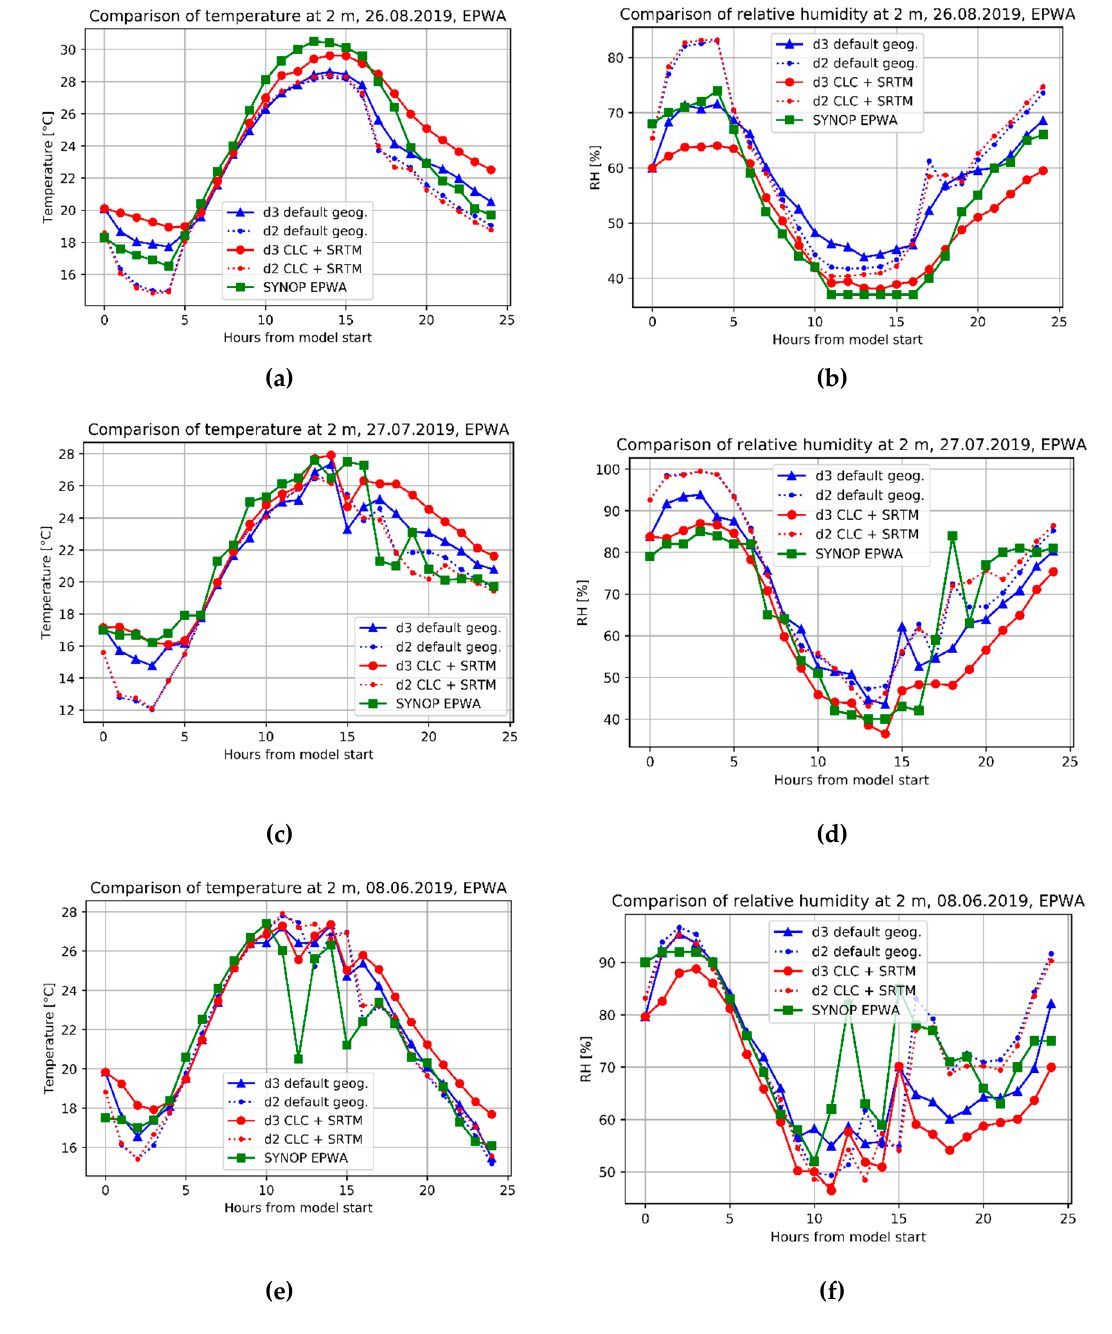
Figure 6. Examples of the obtained values of air temperature and relative humidity at 2 m (AGL) in various synoptic situations: ( a , b ) high-pressure systems; ( c – f ) atmospheric fronts.